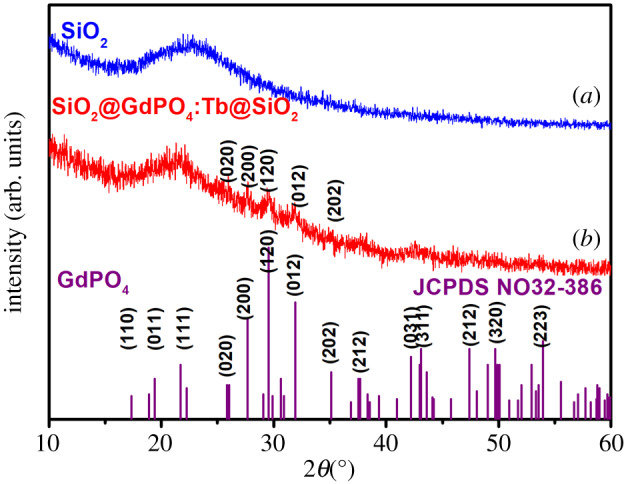
XRD patterns of (a) SiO2, (b) SiO2@GdPO4:Tb@SiO2.